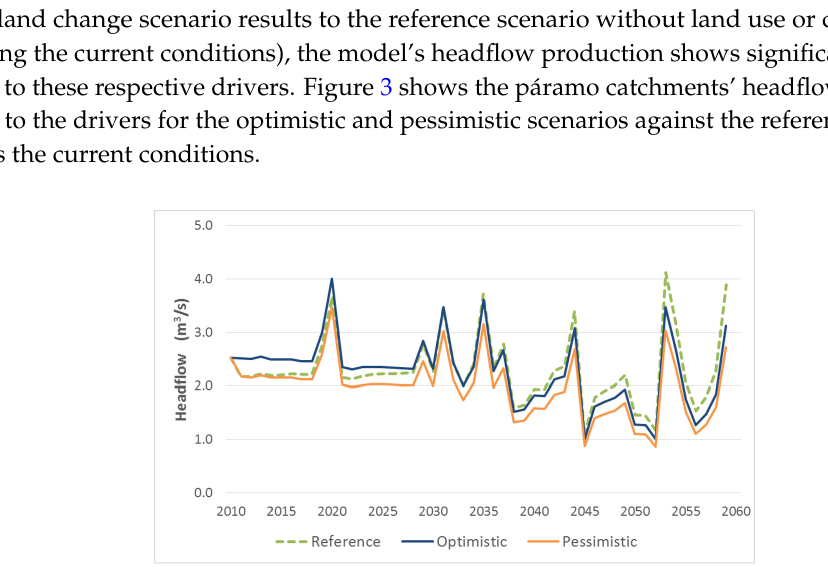
Figure 3. Average annual simulated headflows produced by páramo’s catchments of Quiroz- Chipillico watershed model.